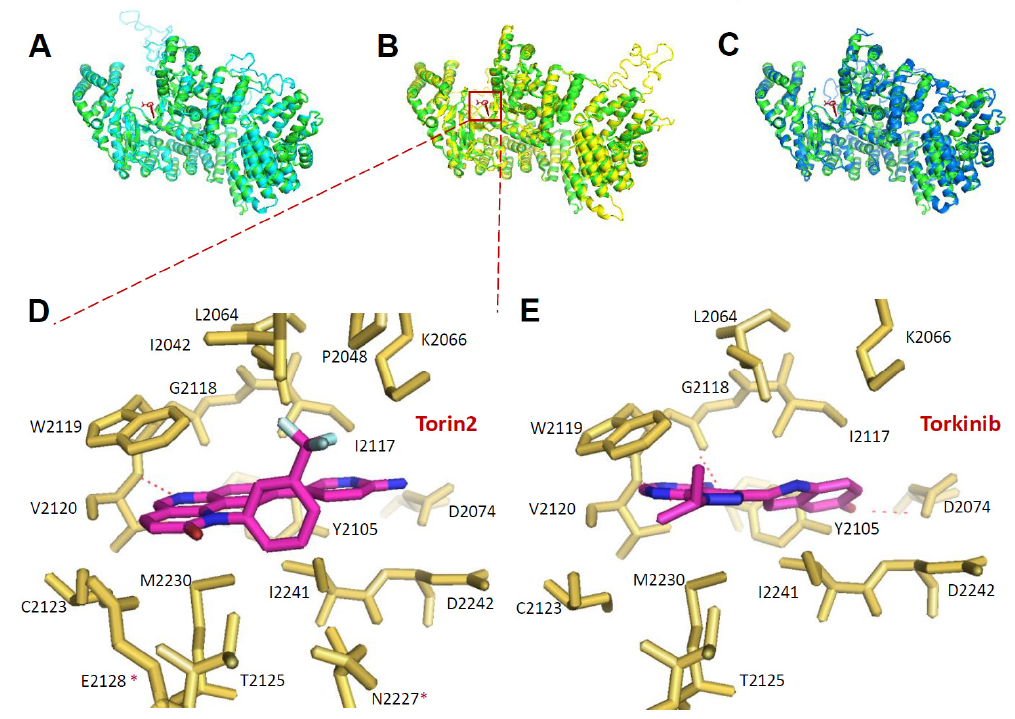
Figure 9. Modeling of L. donovani TOR domains. ( A, B, C ) Structural alignment of Ld TOR1/2/3 and mTORDeltaN-mLST8-Torin2 using PyMOL. The blue cartoon represents the structure of the Ld TOR1, the yellow cartoon represents the structure of the Ld TOR2, and the cyan cartoon represents the structure of the Ld TOR3. The green cartoon represents the structure of the mTORDeltaN-mLST8 and the red stick is the Torin2 structure. ( D ) Structures of Torin2 inhibitor bound to the Ld TOR2 catalytic cleft of L. donovani . Stick representation of Torin2 (C, red; N, blue; F, green) and of Ld mTOR2 residues within 4 Å (except for Asp 2074 and Asp 2242 ). Red-dotted lines indicate atoms within hydrogen-bonding distance. ( E ) Torkinib- Ld mTOR2 structure, represented as in (D), with stick representation of torkinib.